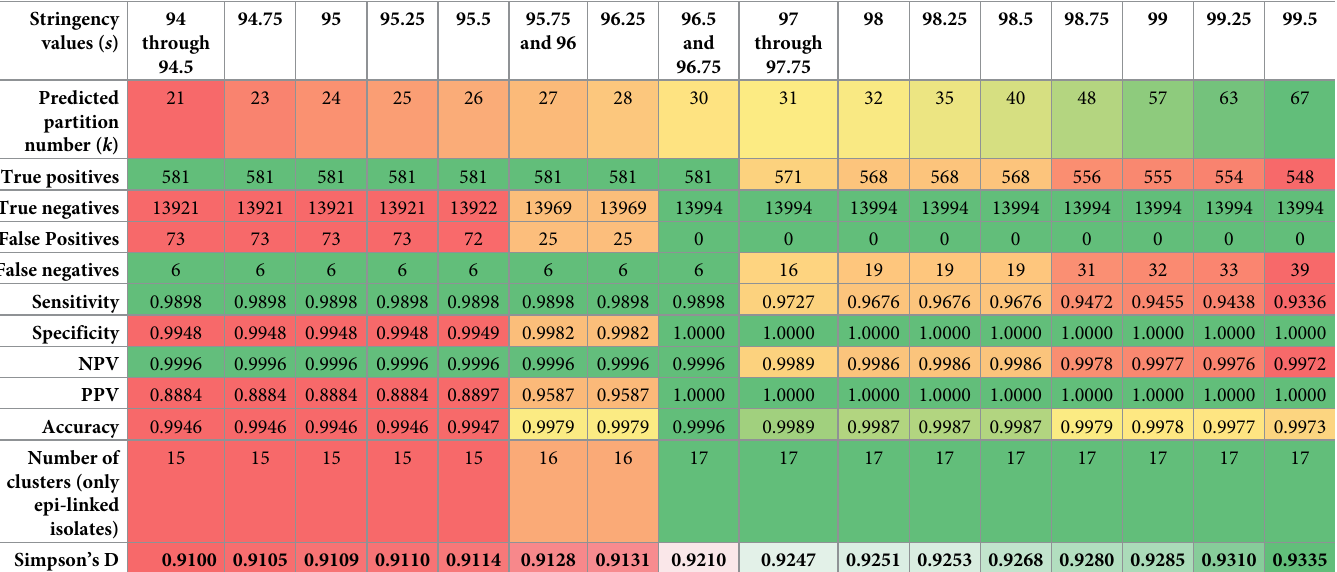
Table 2. Clustering performance for each stringency ( s ) value.